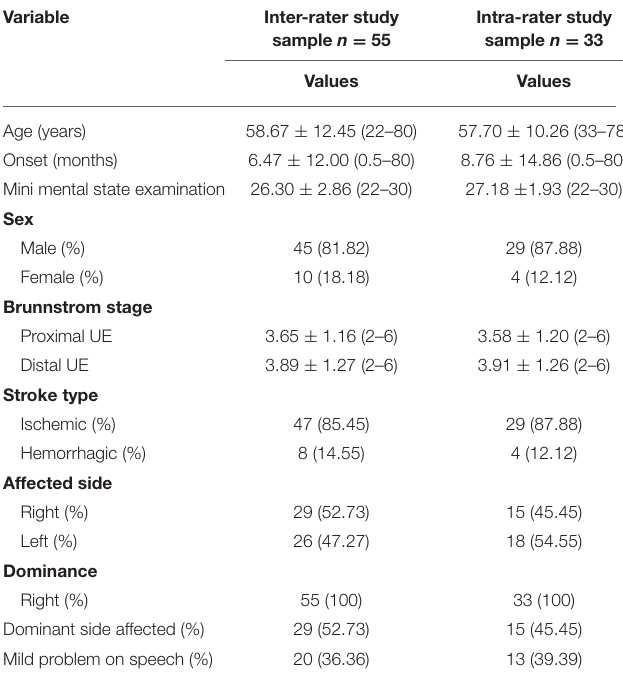
TABLE 1 | Characteristics of the study participants ( n =